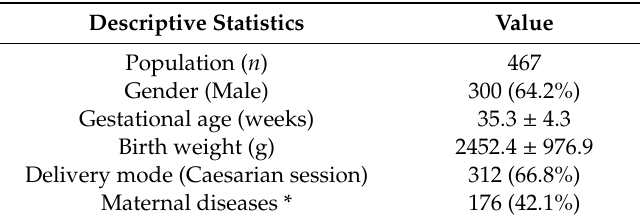
Table 1. Baseline characteristics of the study population.